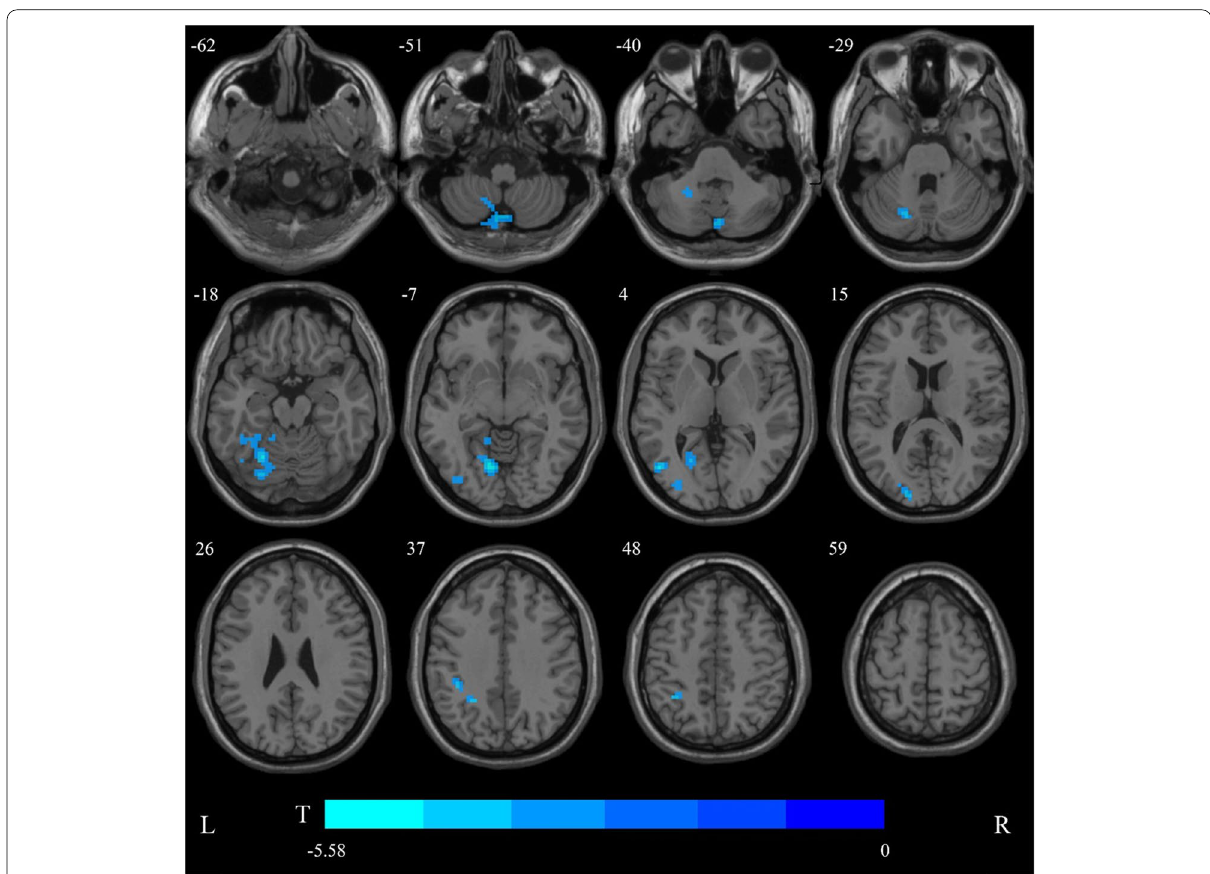
Fig. 2 Aberrant regional homogeneity (ReHo) in the juvenile myoclonic epilepsy patients with monotherapy compared with healthy controls. Cold colors indicate decreased fALFF in the left fusiform/lingual gyrus, the middle occipital gyrus, and the inferior parietal lobe. (voxel-level P < 0.005, cluster-level P < 0.05, corrected for Gaussian random field theory). No regions showed increased